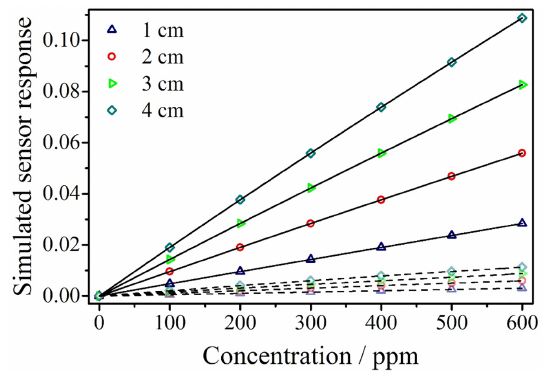
Figure 4. Result of the simulated sensor response for various op- tical path lengths and concentrations in the case of using a pho- toacoustic detector (solid lines) and in the case of a photodetector (dotted lines). The sensitivity increases by about 1 order of magni- tude. E.g. while 600ppm cause a sensor response of >5.5% at 2cm optical path using a photoacoustic detector, the same optical path results in a change of about 0.6% using a